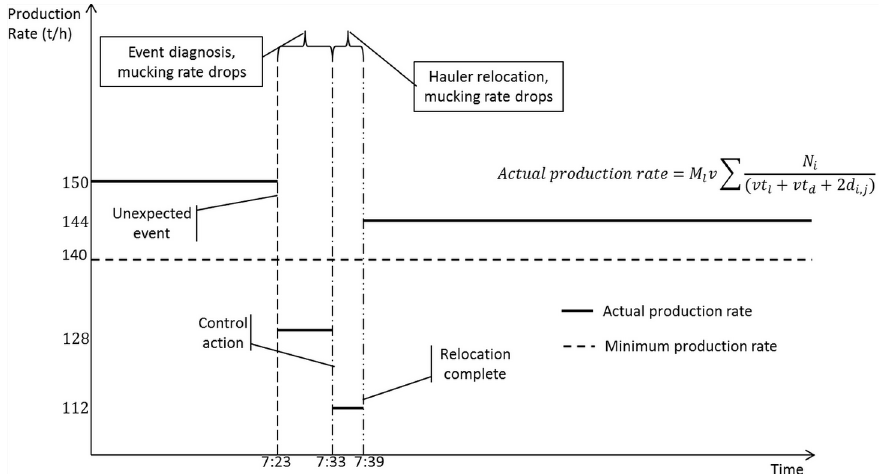
Fig 8. Re-assign the trucks upon an unexpected